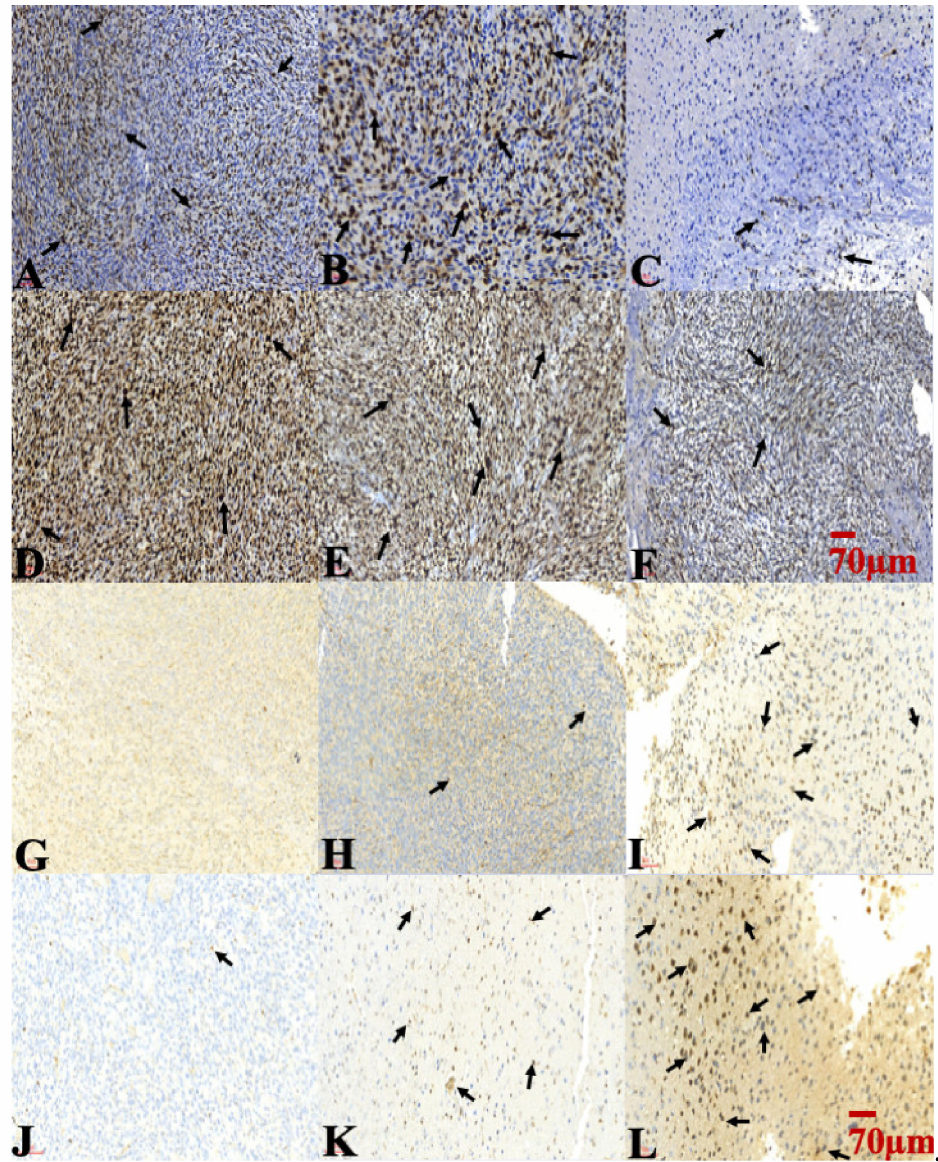
Figure 7. Cell proliferation and apoptosis assay were performed on U87 and U87-TR xenografted tumor regions following treatment with TMZ vehicle, TMZ-combined Gliadel, or TMZ-combined SMPs. ( A – F ) Ki-67 labeling was used to assess cell proliferation, and ( G – L ) TUNNEL assay was used to assess apoptosis. Mice bearing U87 xenografts treated with TMZ vehicle: ( A , G ); TMZ-combined Gliadel: ( B , H ); TMZ-combined SMPs: ( C , I ). Mice bearing U87-TR xenografts treated with TMZ vehicle: ( D , J ); TMZ-combined Gliadel: ( E , K ); TMZ-combined SMPs: ( F , L ). Ki-67 labeling index was performed through MIB-1 immunostaining in each subgroup. The letters in the lower-left corner of each image indicate the subgroup, followed by its Ki-67 labeling index (percentage). The arrows in panels ( A – F ) indicate Ki-67-positive cells. Evaluation of apoptosis of glioma cells by TUNEL assay was performed in each subgroup. The black arrows in panels ( G – L ) indicate TUNEL-positive apoptotic